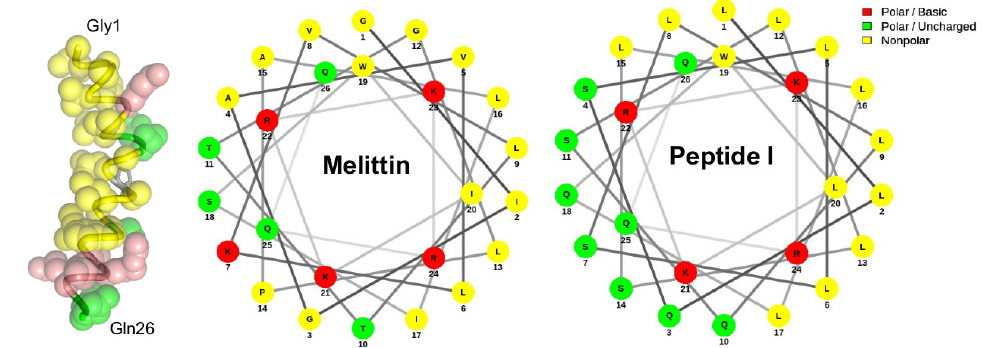
Figure 3. Comparison of the amino acid composition of four AMP classes ( α , β , αβ , and non- αβ ) based on the 721 records of structurally-annotated natural peptides in the APD3 database. proposed that the amphiphilic helix (residues 2–13) is the main driving force for membrane binding. Encouragingly, peptide 1 is engineered with increased amphiphilicity in this segment, resulting in enhanced binding and lytic activity, as confirmed in their experiments. Images were created using PyMOL and NetWheels